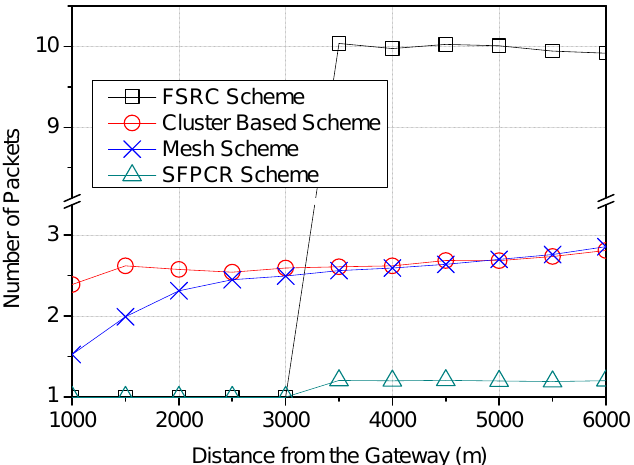
Figure 13. Variation in the number of packets according to the the distance of LoRa devices from the GW with a comparison between the proposed SFPCR scheme and other